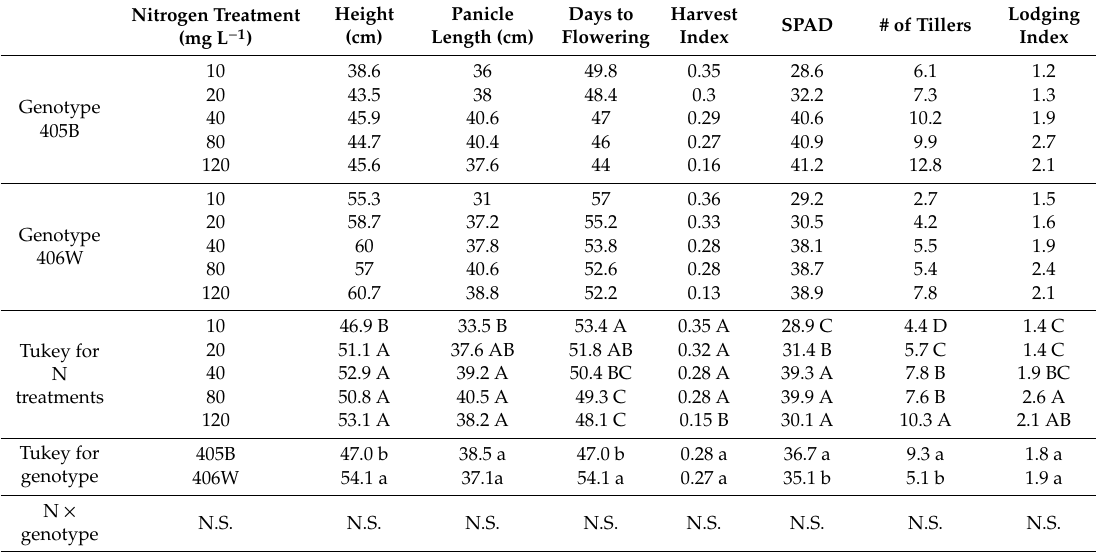
Table 2. E ff ect of N fertigation levels on growth parameters in the winter pot